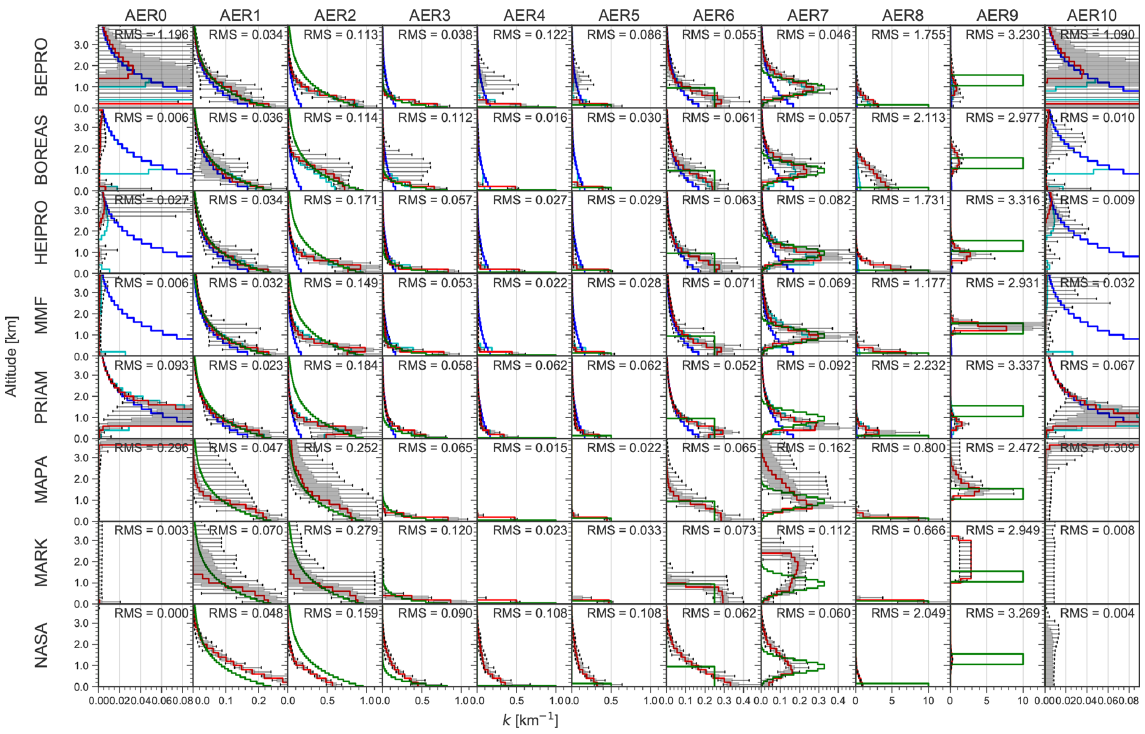
Figure 12. Same as Fig. 11, but for aerosols at